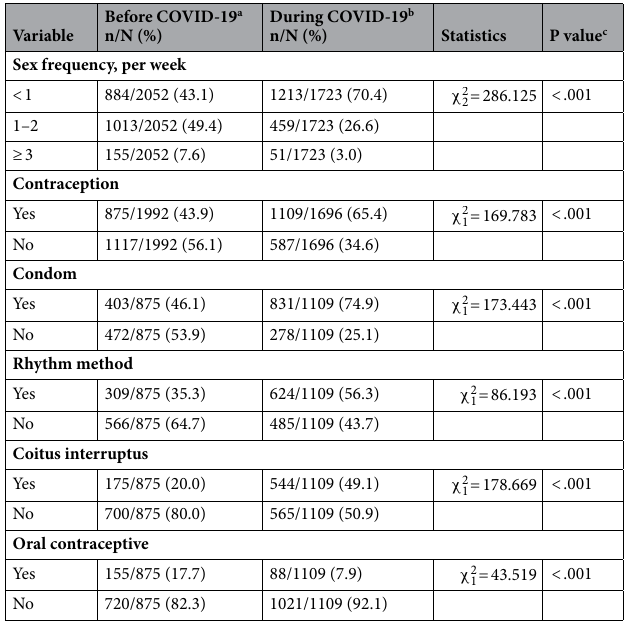
Table 2. Sexual activity and choice of contraceptive methods before and during COVID-19 lockdown. a n = number who answered the question; denominator is not always 2054 because of missing data. b n = number who answered the question; denominator is not always 1735 because of missing data. c Two-tailed χ 2 analysis conducted for significance